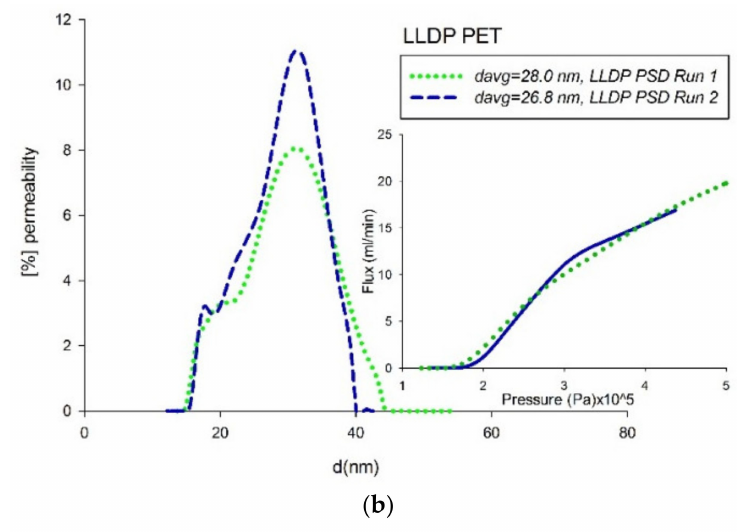
Figure 6. ( a ) Pore-size distributions (PSDs) of the Al 2 O 3 membrane and ( b ) PET membrane as obtained using Liquid Liquid Displacement Porometry.